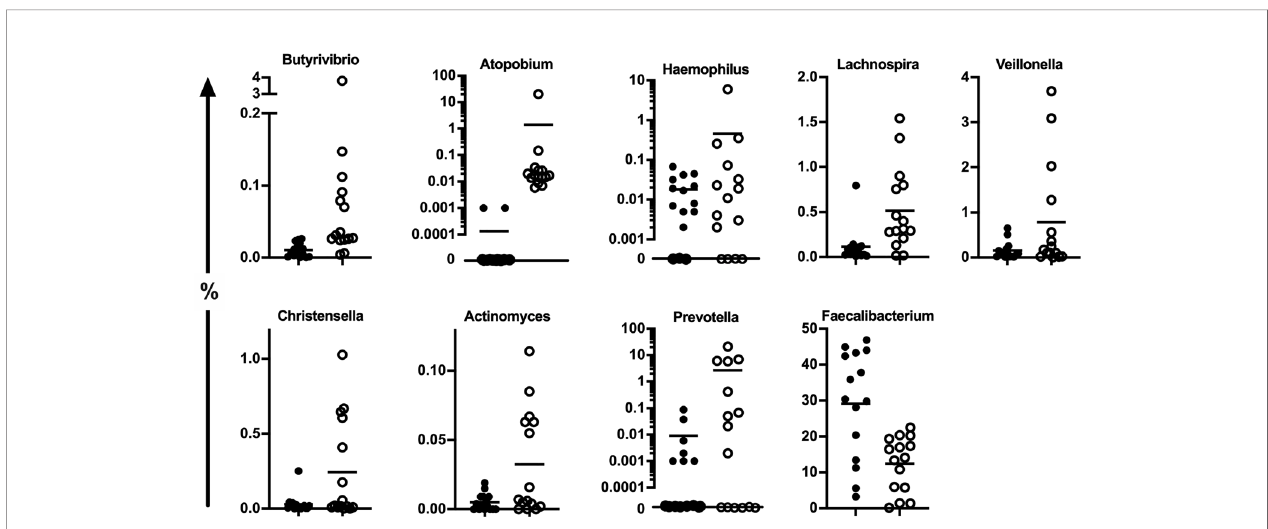
(FDR- P = 0.001, fc = 65 to patients without anti- TPH antibodies).